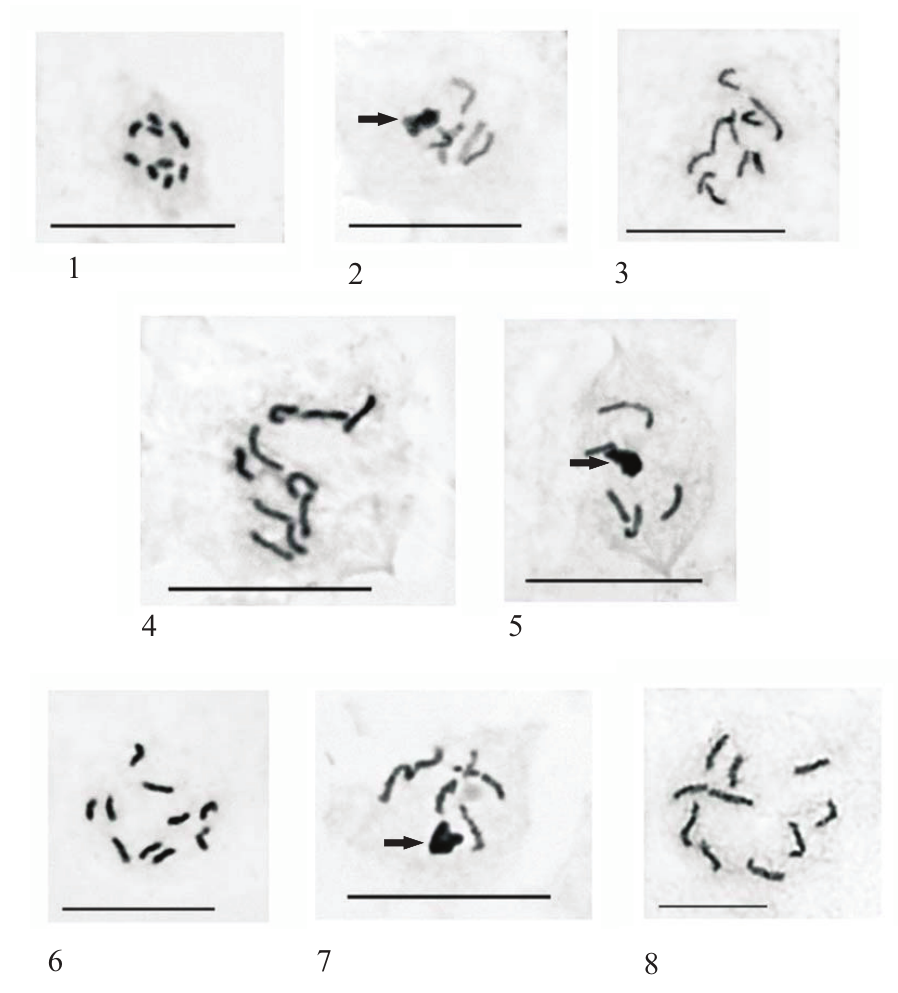
Figs 1-8. Karyotypes of six mealybug species. 1 - Phenacoccus peruvianus , female embryonic cell . 2 - Ph. prope avenae , female embryonic cell. 3 - Ph. hordei , female embryonic cell. 4-5 - Вalanococcus boratynskii ; 4 - female embryonic cell, 5 - male embryonic cell. 6-7 - Trionymus radicum ; 6 - female embryonic cell, 7 - male embryonic cell. 8 - Rhizoecus halophilus , female embryonic cell . Arrows indicate a heterochromatinized haploid set of chromosomes. Bar = 10